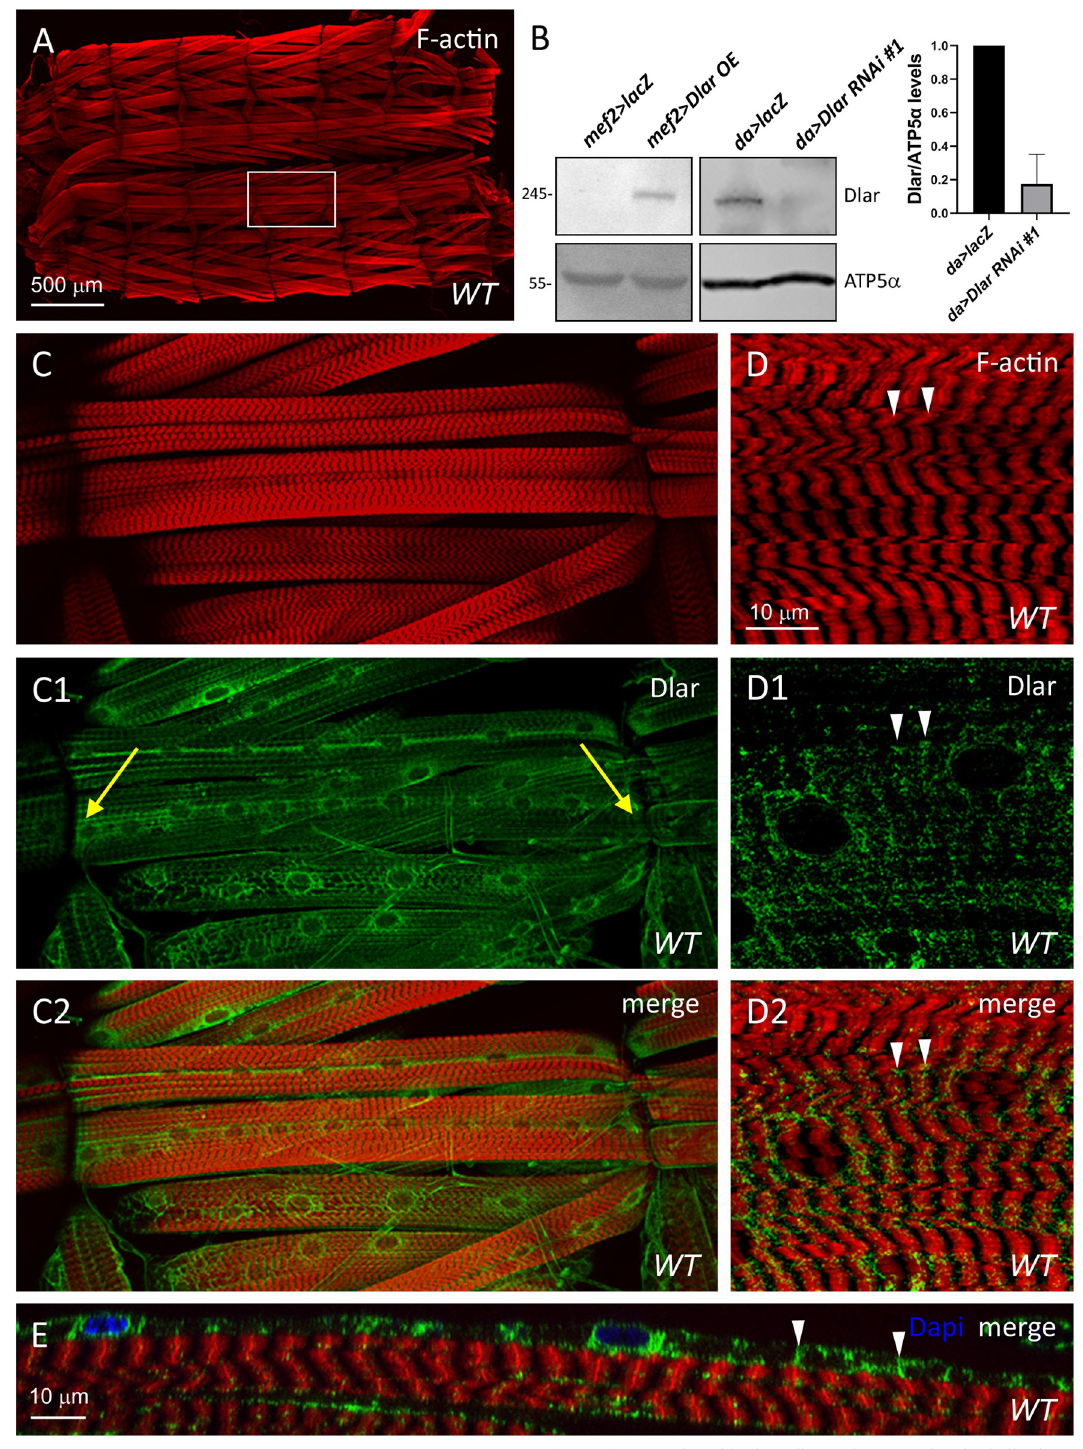
Fig 2. Dlar is localized to the larval muscle membrane at Z-discs. (A,C-E) WT L3 larval body wall muscles stained with phalloidin to label F-actin (red), Dlar (green) or DAPI (blue). (A) Low magnification image of a muscle fillet shows the repeated pattern of body wall muscles across hemisegments. White box indicates ventral longitudinal muscles depicted in C-C2. (B) Western blots of larval lysates using affinity purified rabbit anti-Dlar FN5 or anti-ATP5 α (loading control). Dlar overexpression (Dlar OE) in muscle tissue using mef2-Gal4 obscures the signal of endogenous Dlar in control mef2 > lacZ larvae (left panel). Ubiquitous RNAi knockdown by da-Gal4 results in a decrease in Dlar protein levels (right panel). Bar graph shows the relative levels of Dlar/ATP5 α in control and